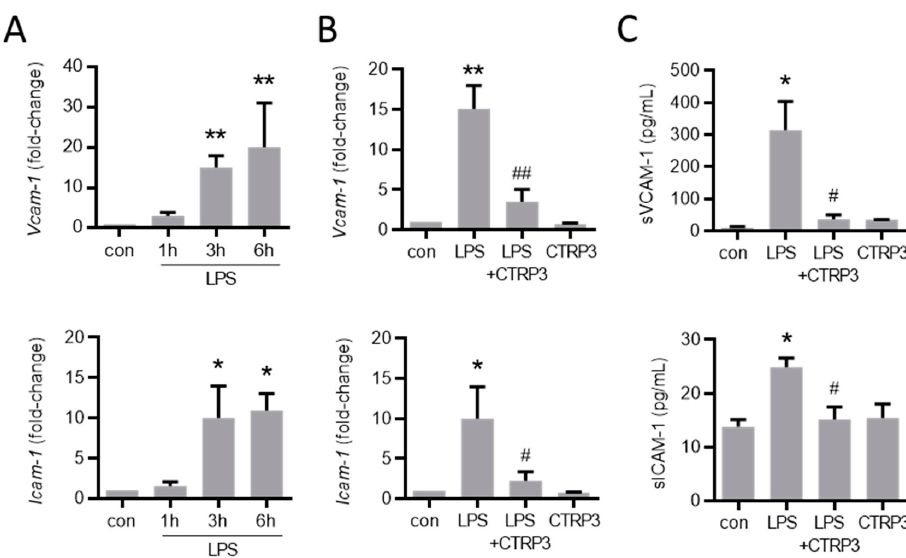
Figure 4. LPS-induced endothelial adhesion molecule expression is inhibited by CTRP3. ( A ) MyEnd (myocardial endothelial) cells were stimulated with LPS (lipopolysaccharides, 50 ng/mL) for the indicated period. Vcam-1 (vascular cell adhesion molecule-1) and Icam-1 (intercellular adhesion molecule-1) mRNA levels were analyzed by real-time PCR. * p < 0.05, ** p < 0.01 vs. con = unstimulated control, n = 5–6. ( B ) MyEnd cells were stimulated with LPS (50 ng/mL) alone or pretreated with CTRP3 (C1q/TNF-related protein 3, 10 µ g/mL, pre-incubation for 30 min) and with CTRP3 alone for 3 h;